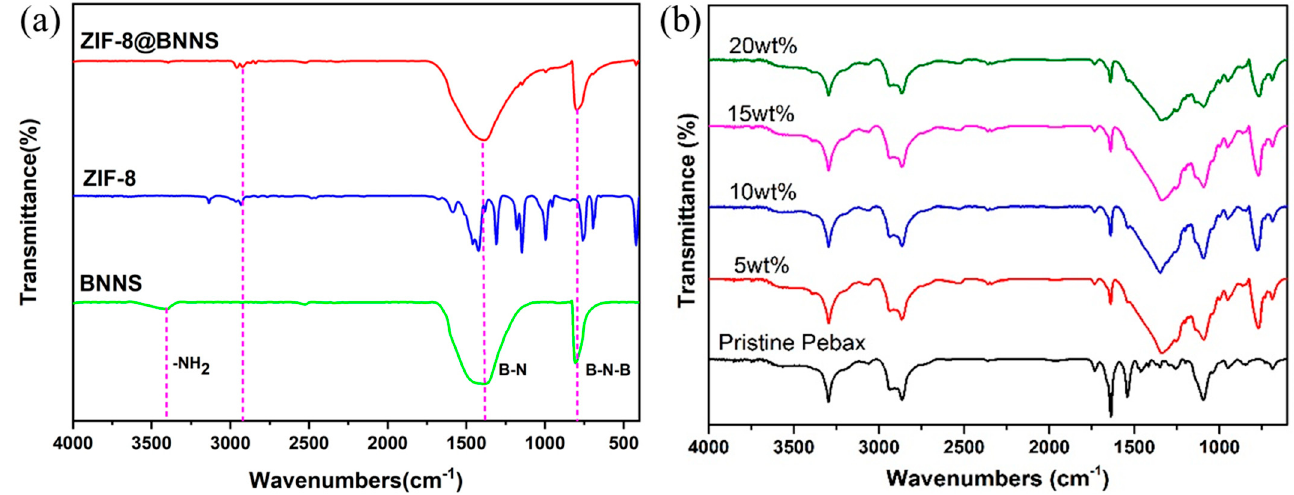
Figure 1. FTIR spectrum of ( a ) ZIF-8, BNNS, and ZIF-8@BNNS and ( b ) Pristine Pebax and